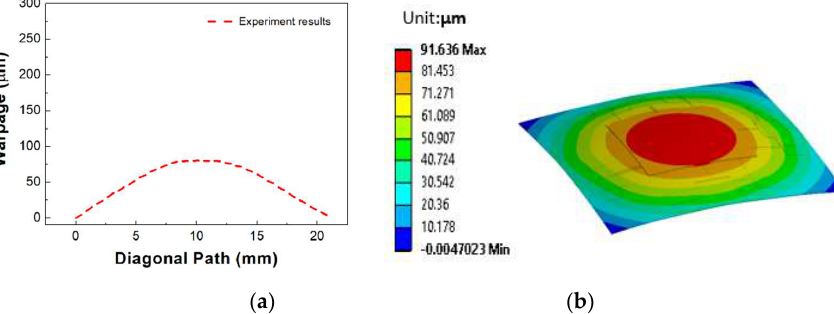
Figure 12. ( a ) Measurement results of the warpage of the flexible package, and ( b ) numerical simulation results of the warpage of the flexible package.